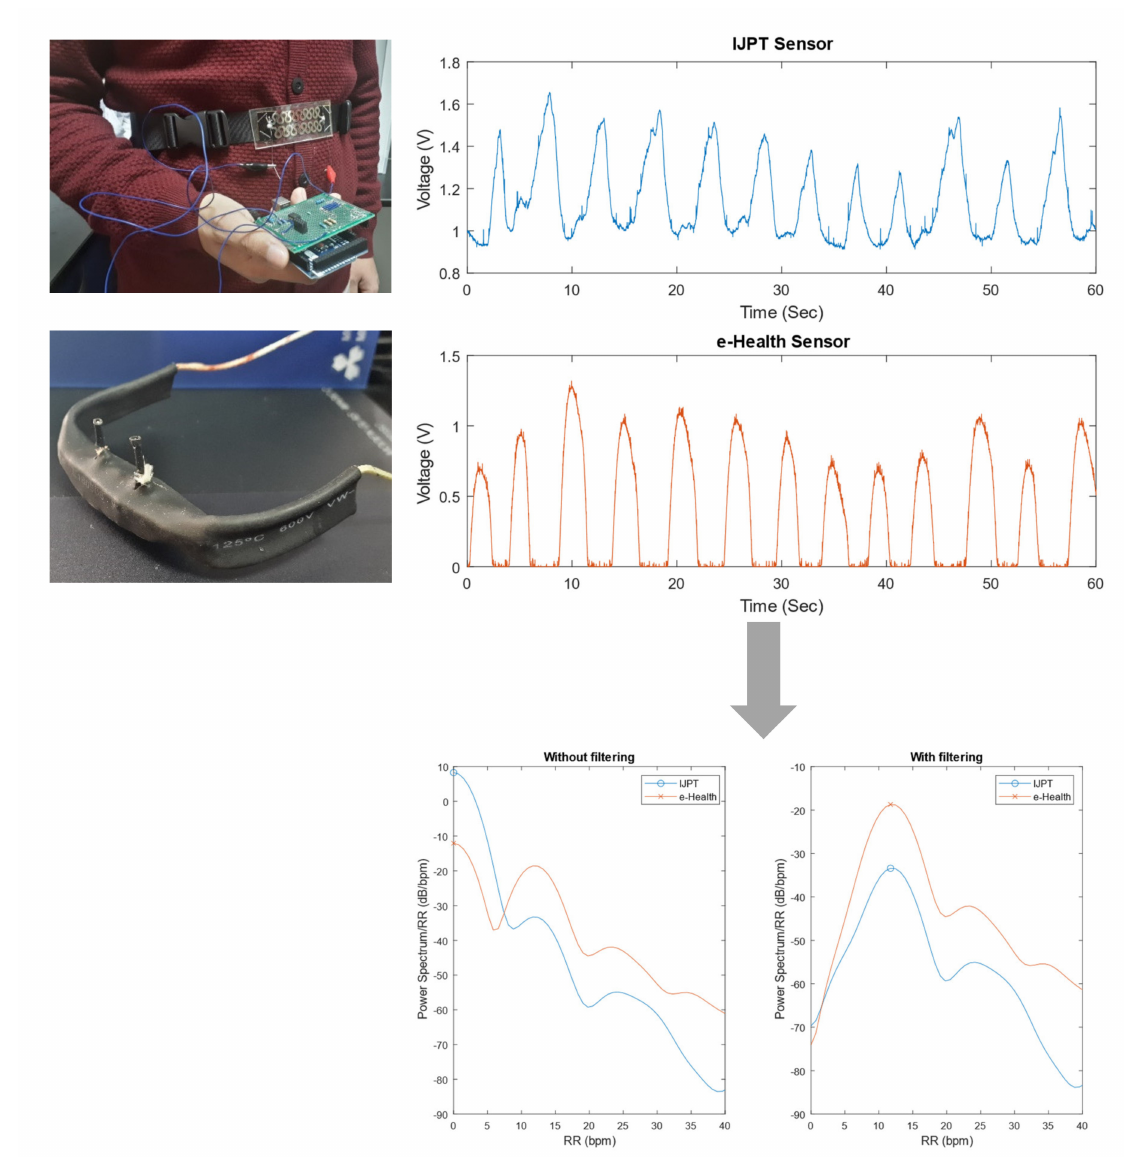
Figure 3. Sample of RR signal processing and RR derivation obtained from patient #9 while sitting using the strain gauge sensor and the e-Health airflow